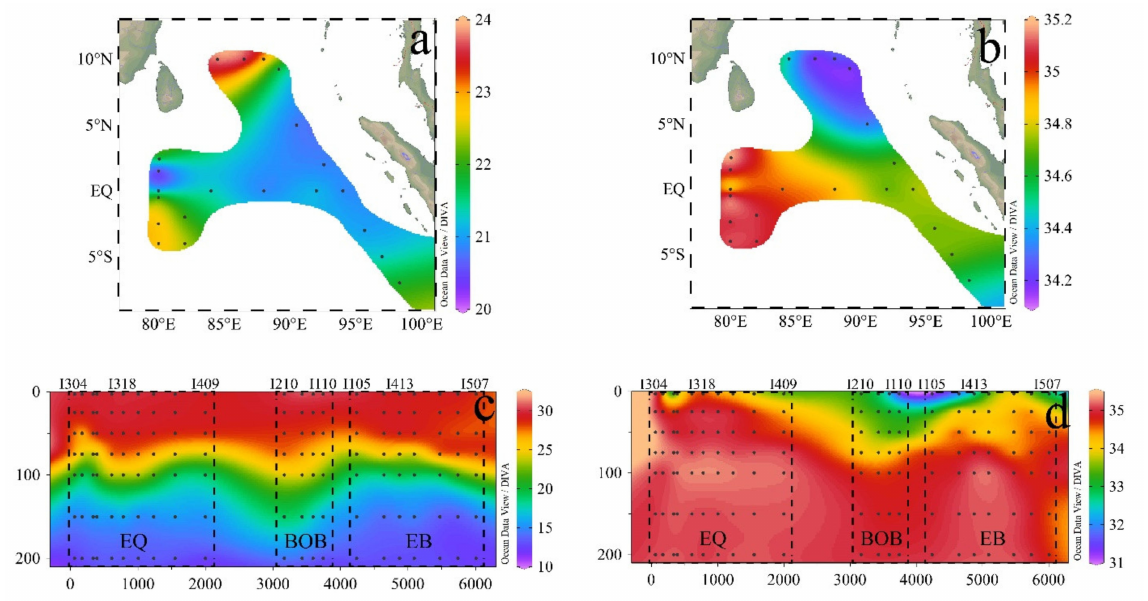
Figure 2. Horizontal distribution(weight-average) of temperature and salinity ( a , b ) and vertical distribution of temperature and salinity ( c , d ). Bay of Bengal (BOB), the Equator (EQ), and the eastern border of the Indian Ocean near Sumatra